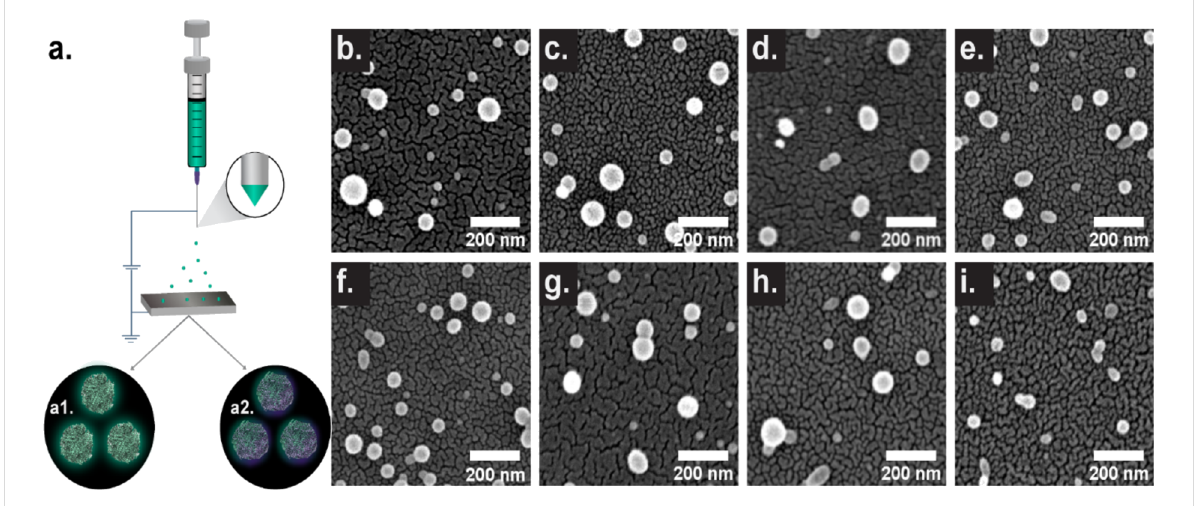
Figure 1: EHD jetting process and SEM images of characteristic SPNPs. (a) Synthesis of various SPNPs comprised of (a1) single proteins or (a2) binary protein blends, and PEG macromers. (b–i) SEM images of single protein and blended SPNPs. (b) HEM/HSA, (c) TF/HSA, (d) MUC/HSA, (e) INS/HSA, (f) HEM, (g) TF, (h) MUC, (i) INS. Scale bar: 200